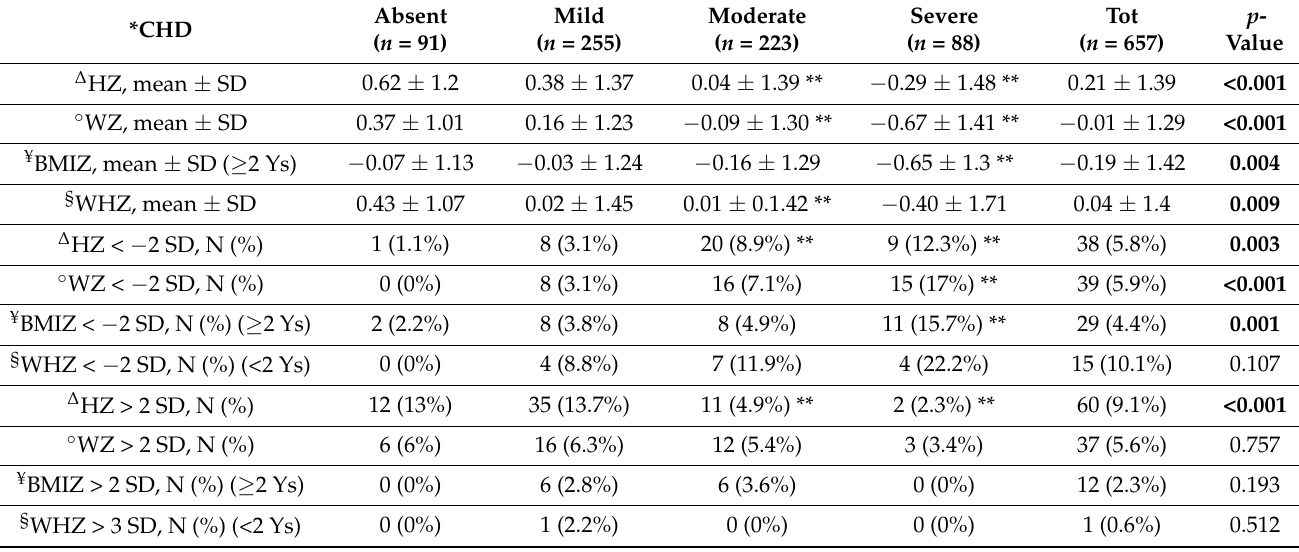
Table 1. HZ, WZ, BMIZ and WHZ in CHD severity groups. The frequency ofwasting underweight, stunting, overweight, obesity and tall stature in the different groups is reported.